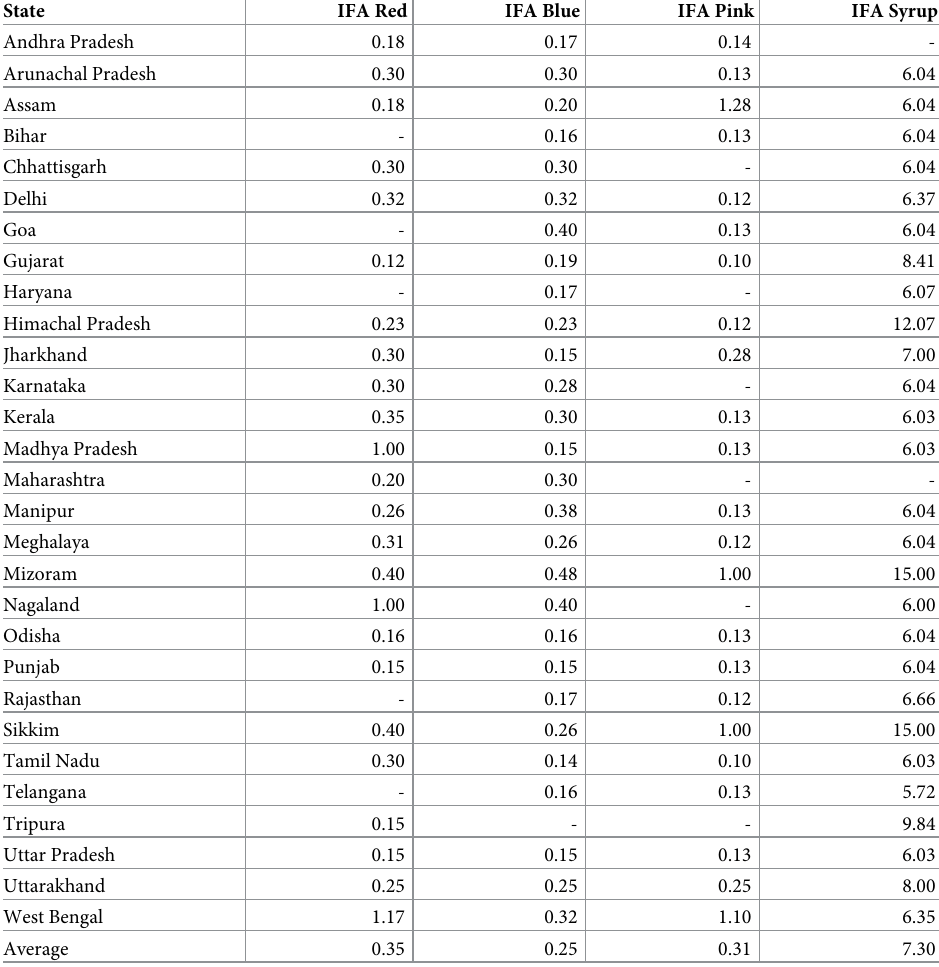
Table 4. Estimated unit cost of IFA supplements (tablets / syrups) by states / UTs,